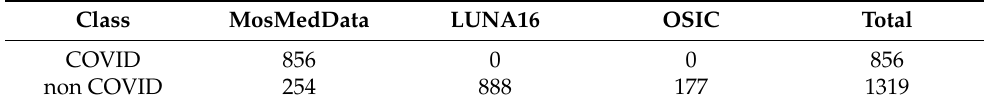
Table 2. Number of computed tomography (CT) Scans by Source dataset.